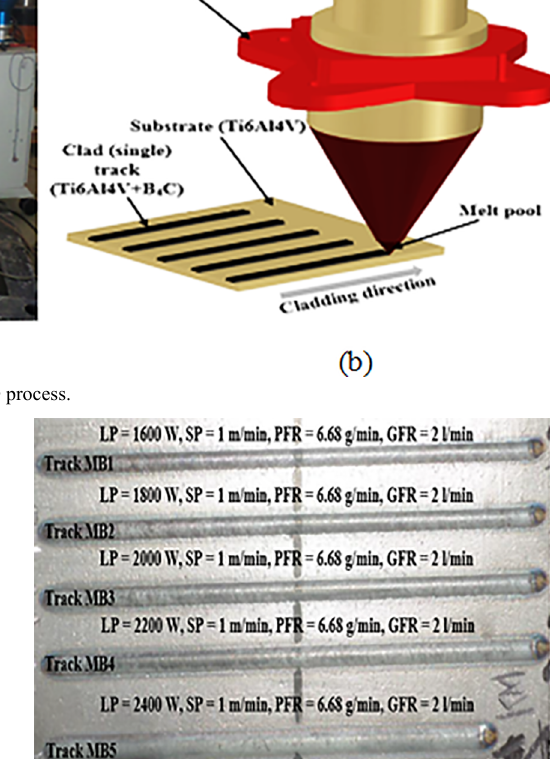
Figure 2. Physical appearance of the Ti6Al4V+B respect to laser